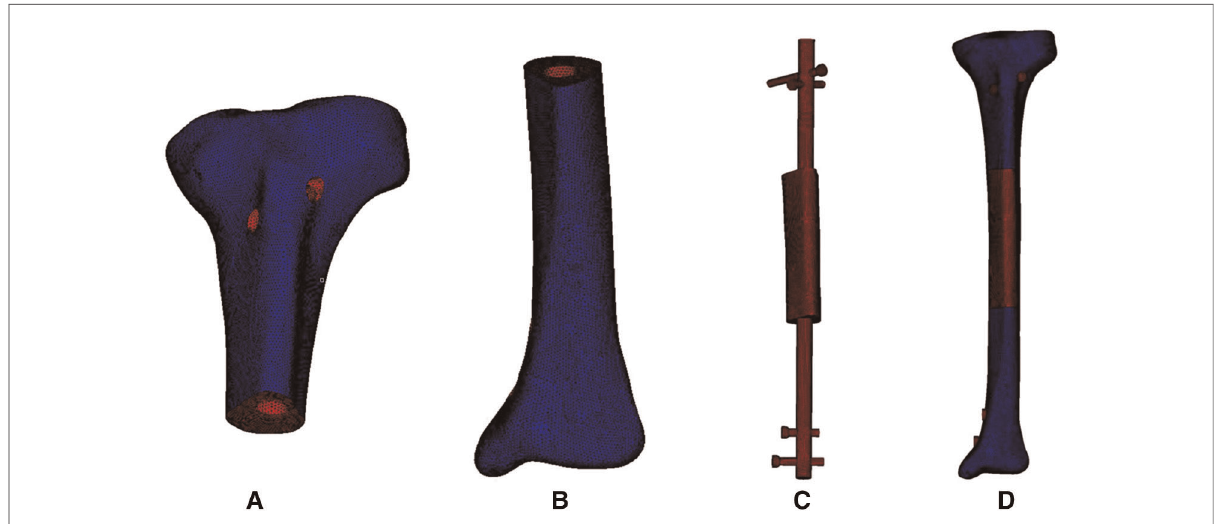
FIGURE 3 Meshing of the 3D model of the bone, intramedullary nail and prosthesis. ( A ) Meshing model of proximal tibia. ( B ) Meshing model of distal tibia. ( C ) Meshing model of internal fi xation and prosthesis. ( D ) Meshing model of the integral